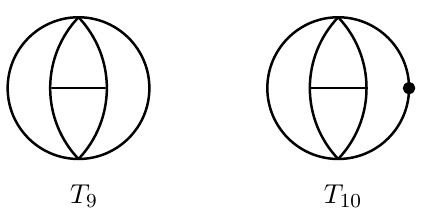
Figure 3 . Master integrals. Solid lines correspond to the propagators 1 = ( k 2 (cid:0)